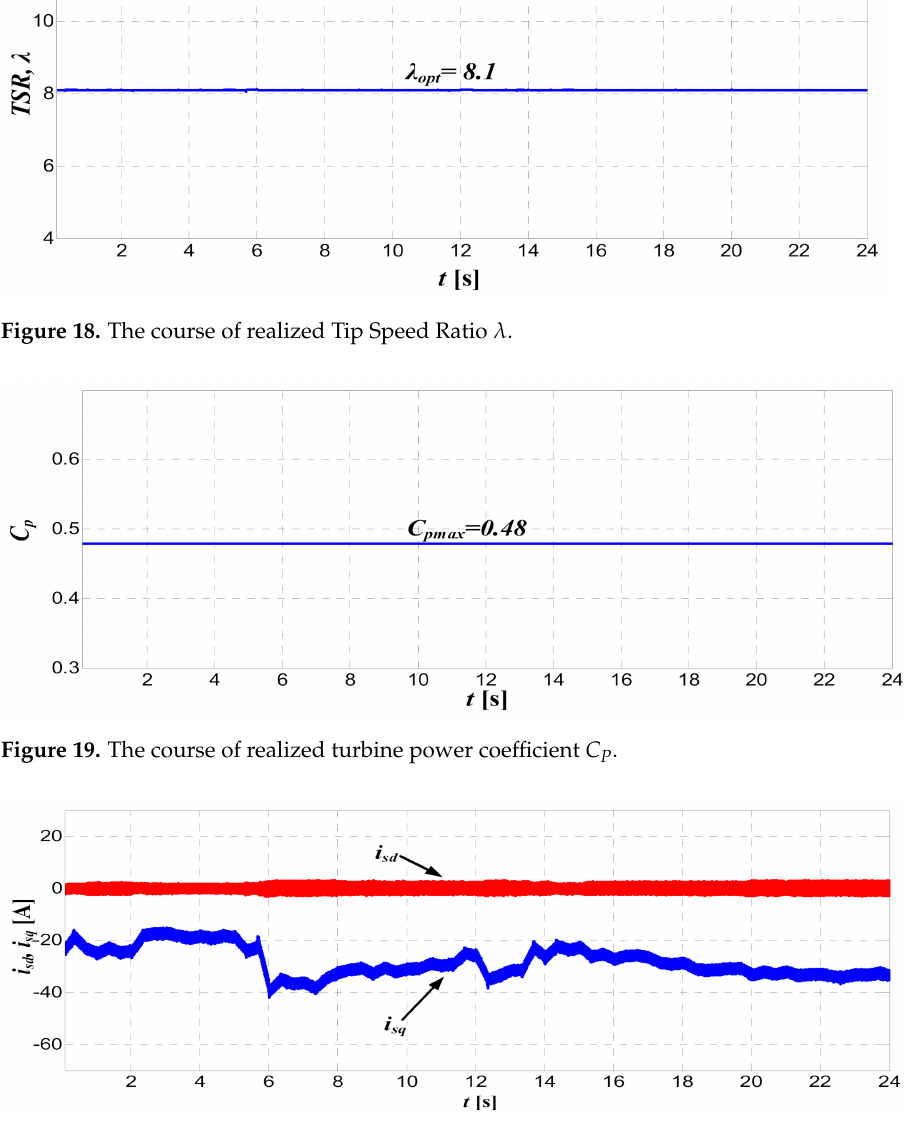
Figure 20. The courses of components i sd , i sq of stator current vector of